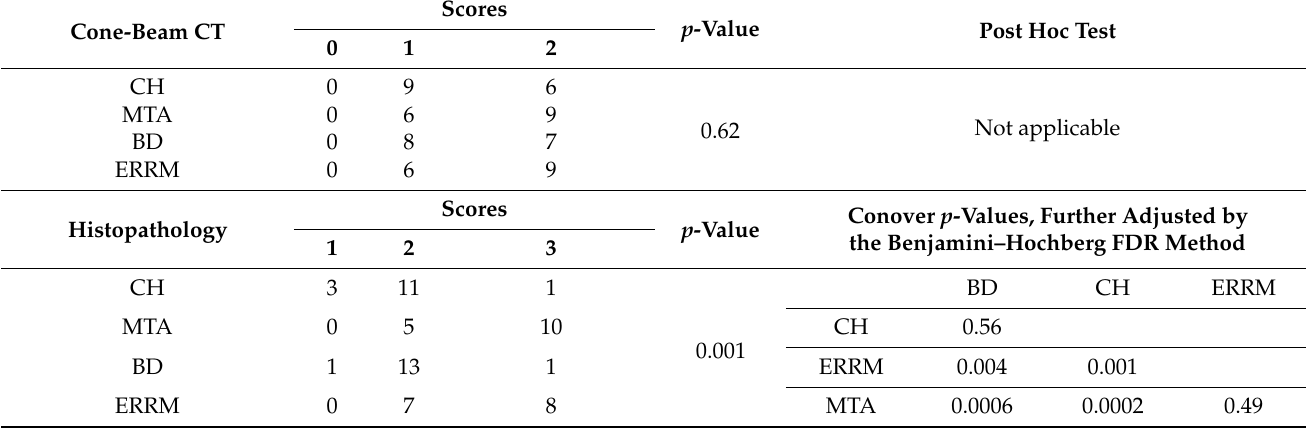
Table 2. The statistical analysis of the four pulp-capping groups (Kruskal–Wallis test, p < 0.05 is significant). Cone-Beam